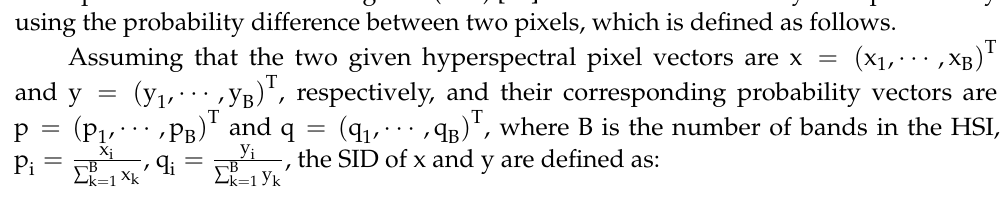
Table 1. Parameters of RX methods.